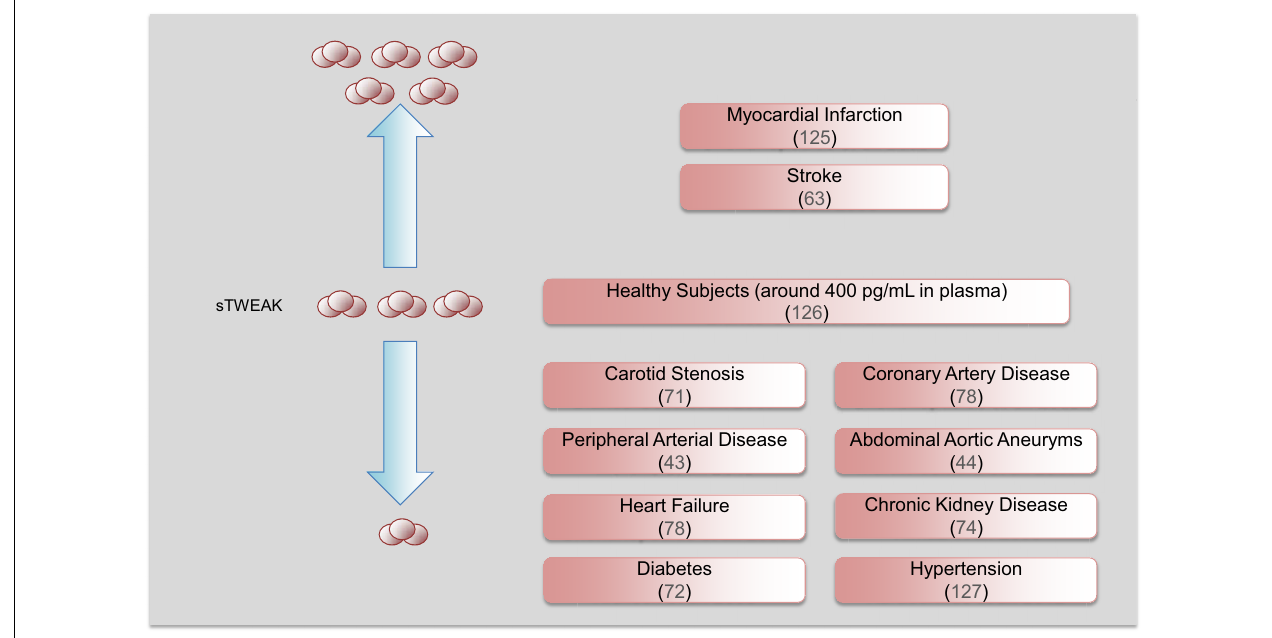
chronic kidney disease. SolubleTWEAK levels are also diminished in subjects with cardiovascular risk factors such as diabetes or hypertension. However, circulating sTWEAK levels are increased in patients suffering an acute cardiovascular event (myocardial infarction or